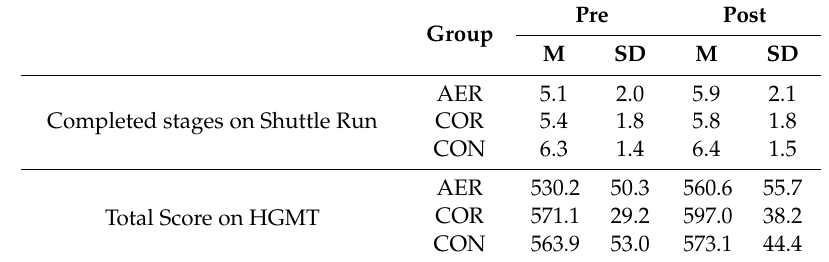
Table 2. Behavioral performance on the Flanker task at pre- and post-test displayed for each